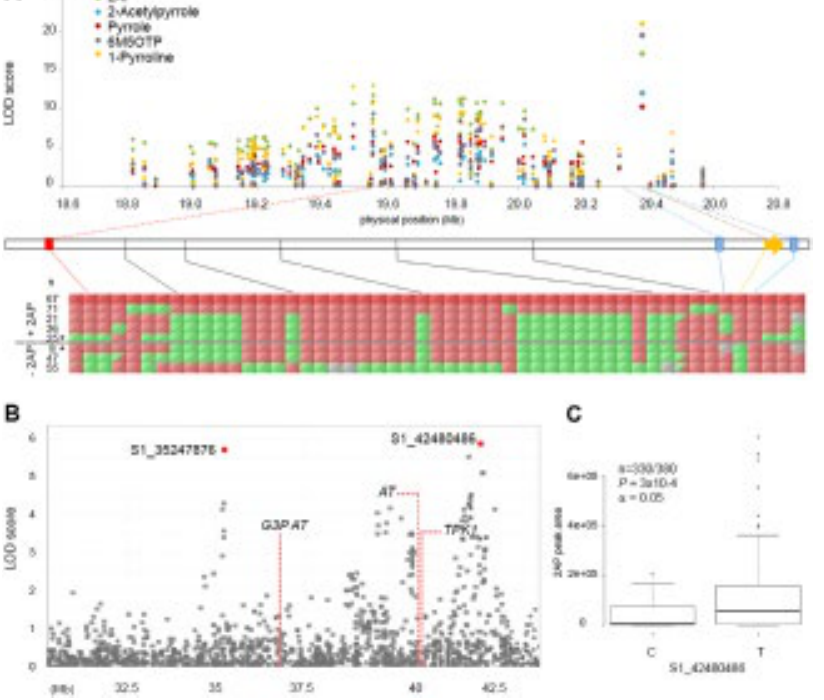
Figure 3. GWAS of 2AP and linked compounds. ( A ) Physical distribution of the most significant SNPs in chromosome 8. The functional markers for FGR (diamonds) outperformed the MS SNPs (S8_19555833) for each of the five compounds. Lines connecting ( A , B ) denote the position of the S8_19555833 (previously MS SNP, red line) and the SNPs closest to FGR (SNPs S8_20311425 and S8_20408314, blue lines) relative to FGR (orange arrow). ( B ) Representative haplotypes of the population. Red cells represent SNPs identical to the aromatic line KDML 105, heterozygotes are represented by half-filled cells, while grey are missing data. The number of lines carrying each haplotype is indicated in the table. Asterisk denotes the haplotypes where linkage breaks between the MS SNP S8_19555833 are not predictive of the presence or absence of aroma, explaining the lower LOD score of SNP S8_19555833. ( C ) Zoom in of the QTL region on chromosome 1. The most significant SNPs (MS SNPs) are denoted in red. Location of the candidate genes are shown by dotted lines. ( D ) Box plot for the 2AP levels at different alleles of the MS SNP S1_42480486. The middle line indicates the median, the box indicates the range of the 25th to 75th percentiles of the total data, the whiskers indicate the interquartile range and the outer dots are outliers. n shows the number of samples used to make the plot over the total number of samples, p and α denote the p-values and alpha,